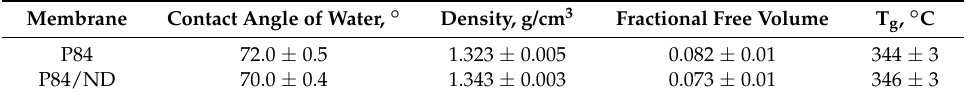
Table 2. Physical properties of membranes.